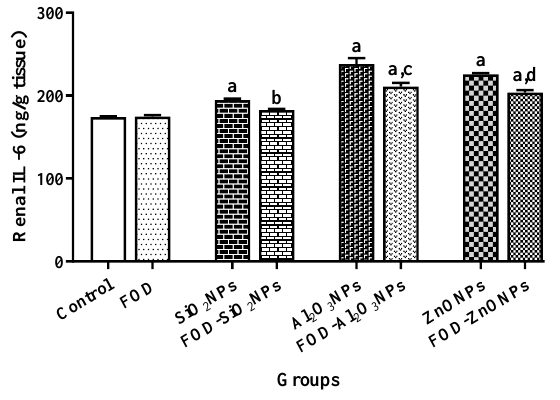
Fig. 2. The effects of fig with olive oil and date-palm fruit extracts (FOD) on the renal interleukin-6 (IL-6) in rats treated with different nanoparticles (NPs) for 75 days. a p<0.05, versus control group; b p<0.05, versus SiO 2 NPs; c p<0.05, versus Al d p<0.05, versus ZnONPs. N.B: 2 O 3 NPs; The antioxidants (FOD) treatments were used for 2 weeks before and during the administration of the nanoparticles.